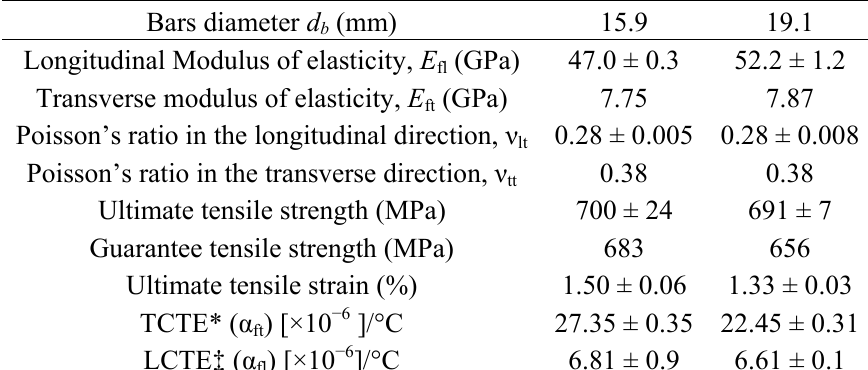
Table 2. Mechanical and thermal properties of GFRP reinforcing